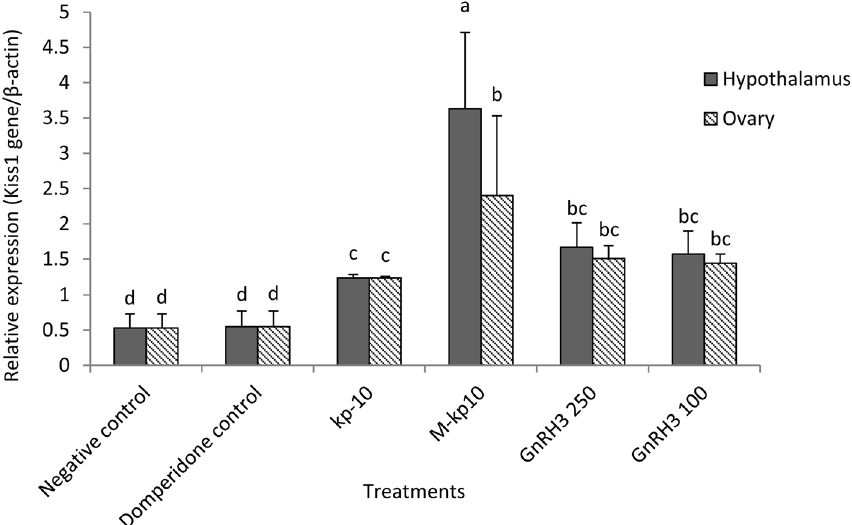
Figure 3. Changes in the expressions of kiss1 gene in the ovarian and hypothalamus tissues of female goldfish based on the RT-PCR (The actb is considered as the control). The different letters above columns are showing significant differences based on one-way ANOVA and Tukey’s post hoc